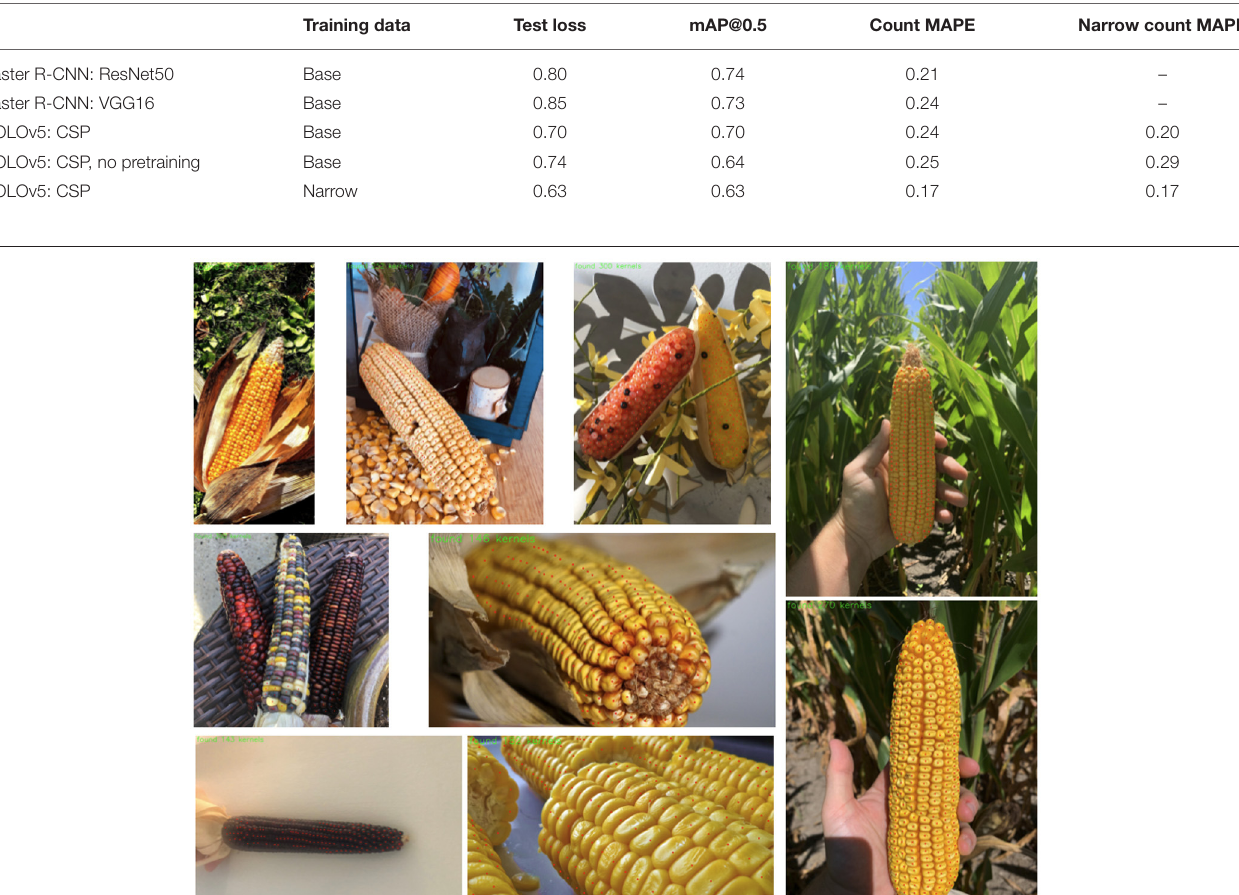
TABLE 1 | Detection model performance.